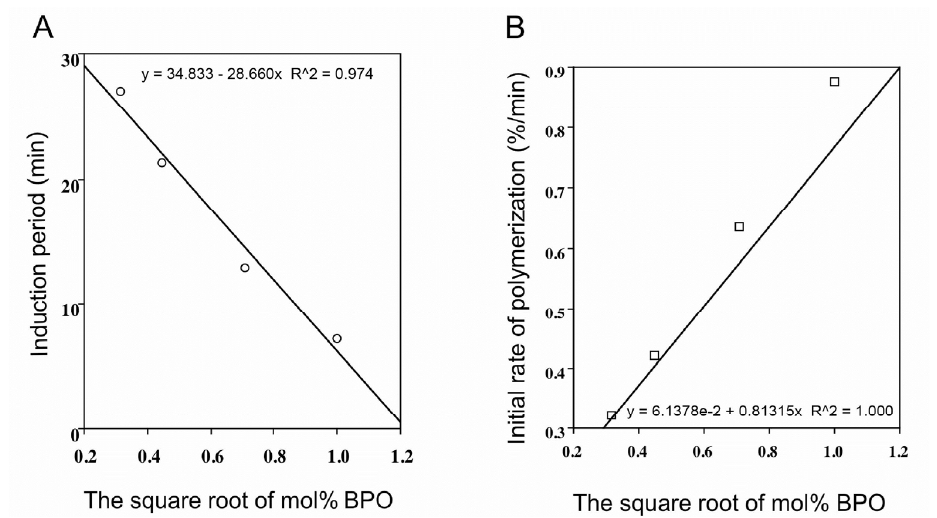
Figure 3. Relationships between induction period ( A ) or initial rate of polymerization ( B ) and the square root of mol% of BPO.